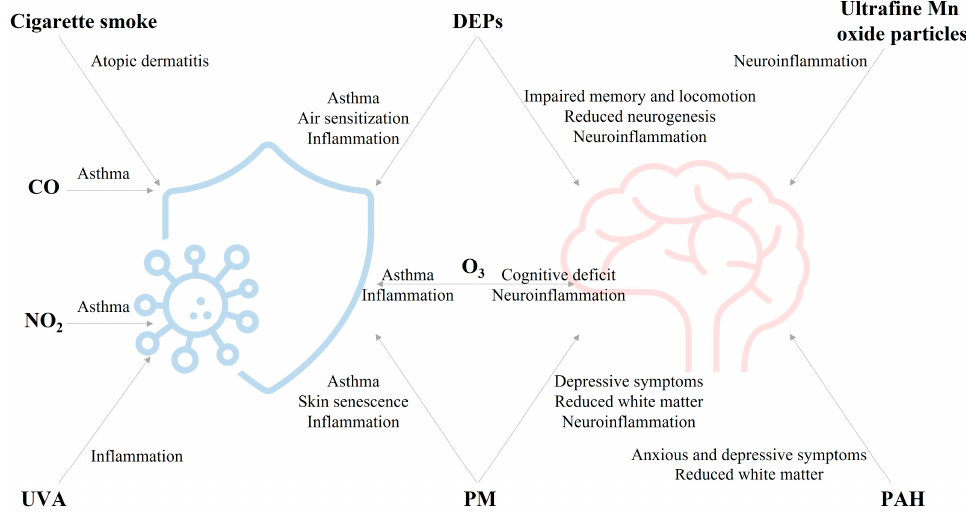
Figure 2. Main effects of air pollutants on immune and nervous system. Summary of the results reported in Tables 2 and 3.